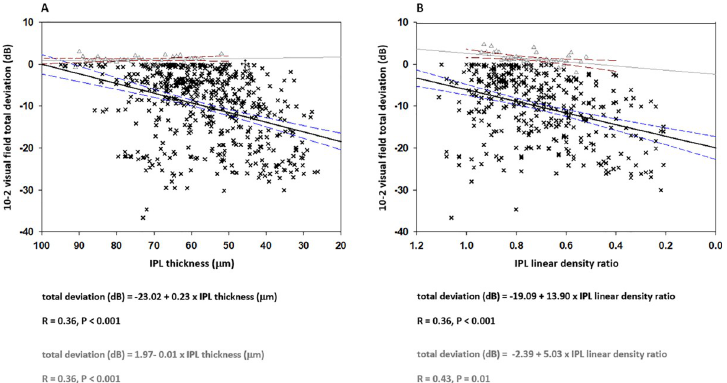
Fig 3. Sequential analysis of the association between IPL and visual field alterations in patients with glaucoma. Presented include the scatterplots showing a significant relationship between the alterations in IPL thickness and visual field scores ( A ), and alterations in IPL linear density and visual field scores ( B ) over the two-year follow-up. Dashed lines show the 95% confidence intervals for glaucomatous eyes (black solid line) and non-glaucomatous controls (gray solid